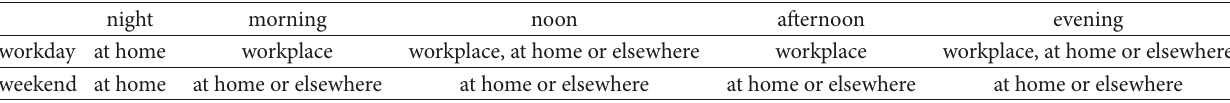
Table 3: The rules for determining the location